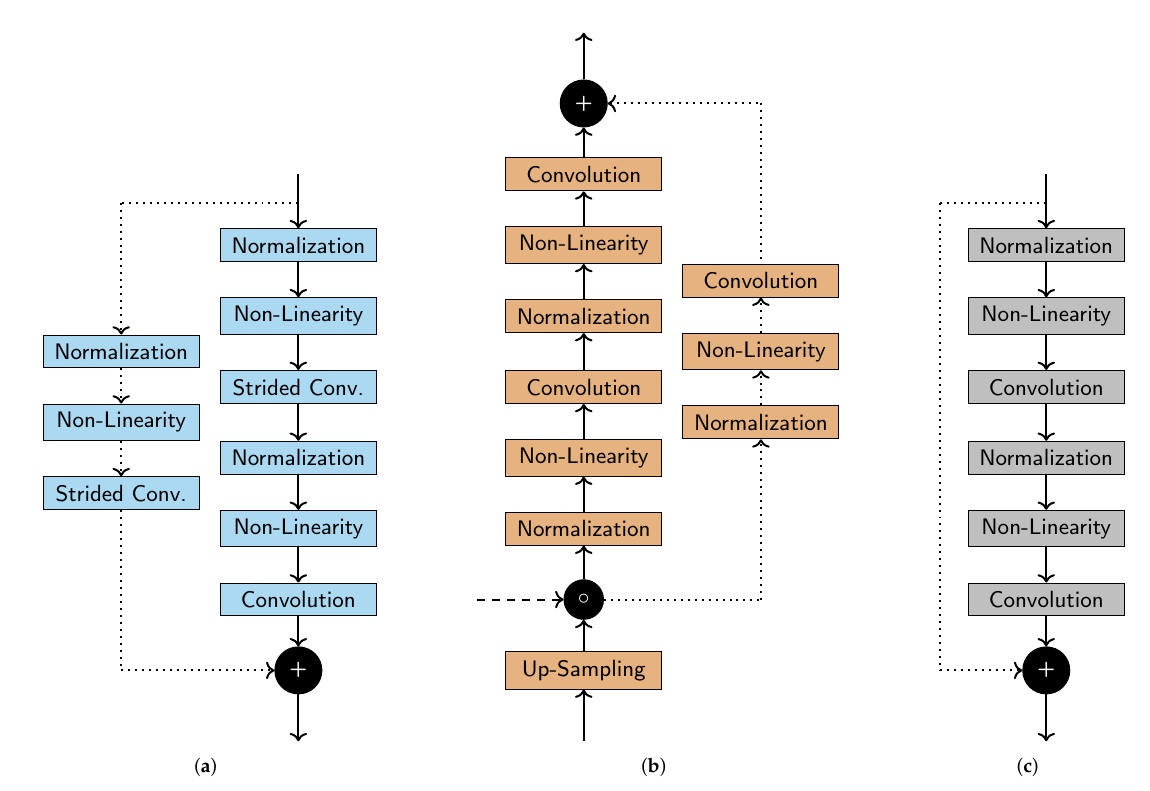
Figure 3. Detailed illustration of the used architecture blocks of our network, used for down- ( a ) and up-sampling ( b ), as well as a residual block ( c ). Down-sampling is realised with strided convolutions, whereas deterministic up-sampling is used. Concatenation of tensors in the channel dimension is denoted as ◦ . Addition of tensors of the same size is denoted as + .